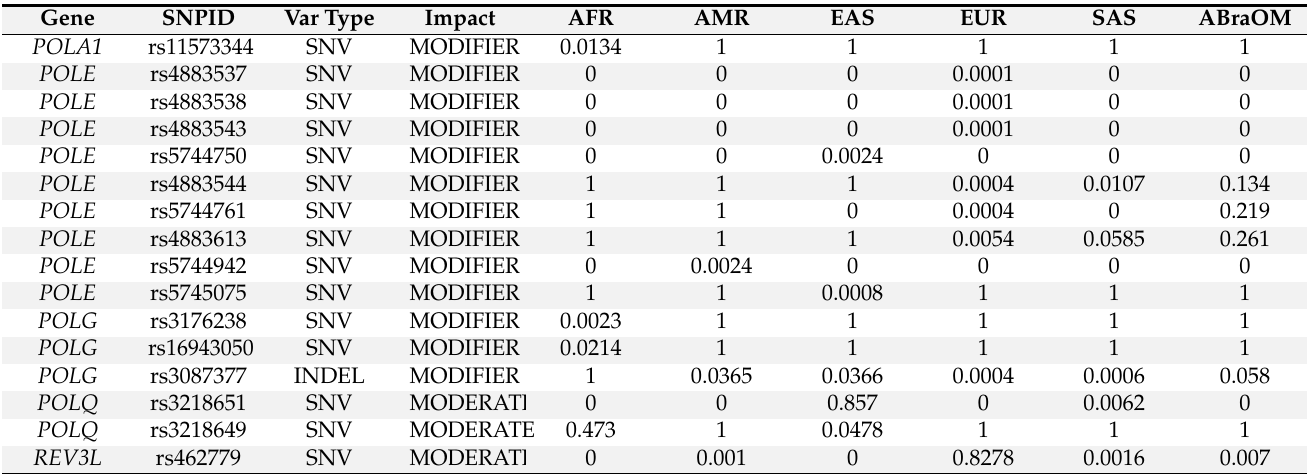
Table 3. Pairwise comparison ( p -value) of allelic frequencies in Amerindians (NAT), the Brazilian population described in ABraOM and continental populations (African (AFR), American (AMR), East Asian (EAS), European (EUR) and South Asian (SAS) populations) described in the gnomAD